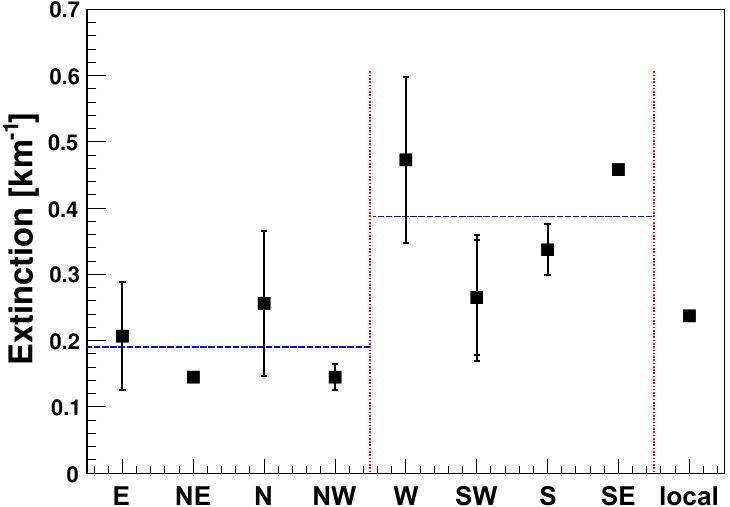
Figure 9. Mean aerosol extinction within the ABL depending on the origin of the air mass. Error bars represent the standard deviation of the measurement